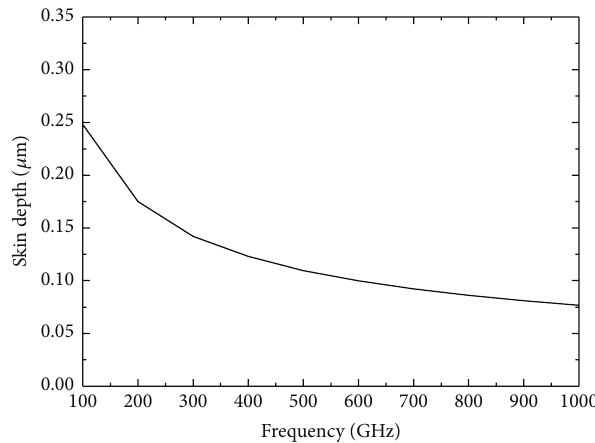
Figure 2: The skin depth of the smooth gold film at 100 ∼